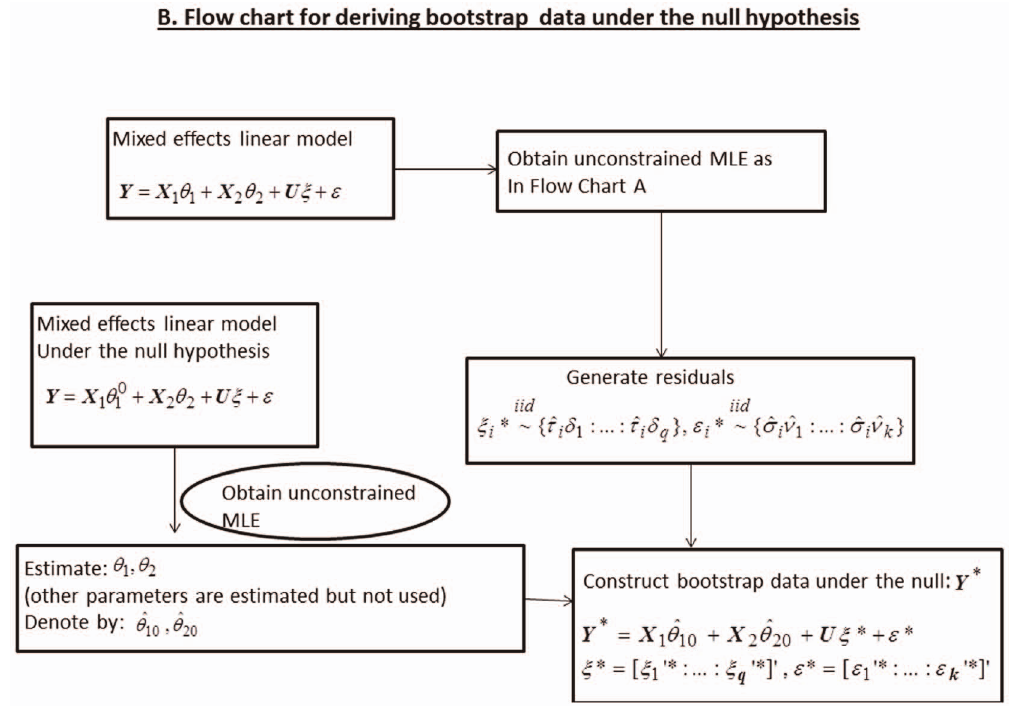
Figure 3. Flow chart for deriving Bootstrap data under the null hypothesis.